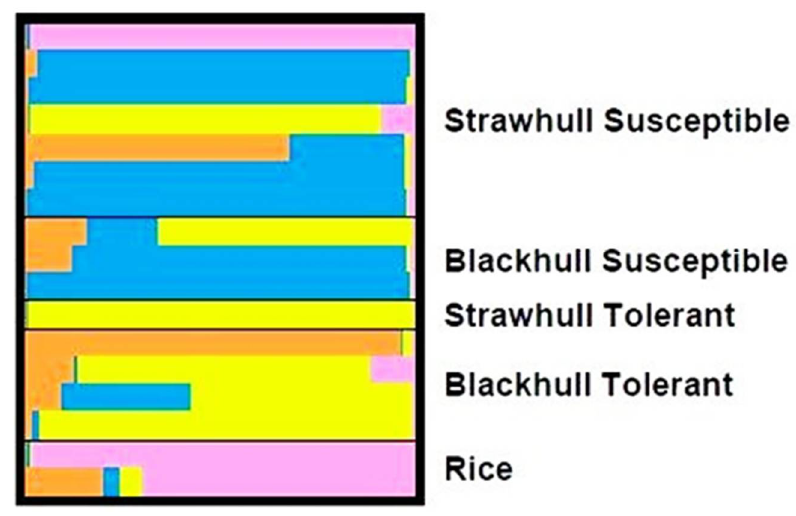
Figure 3. Population structure of accessions based on herbicide tolerance.